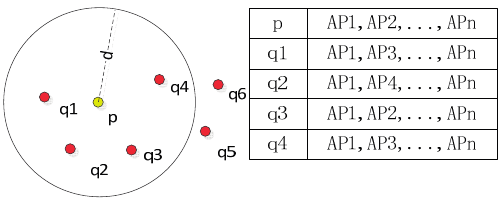
Figure 7. The spatial distance-mean filter for WiFi fingerprint feature information